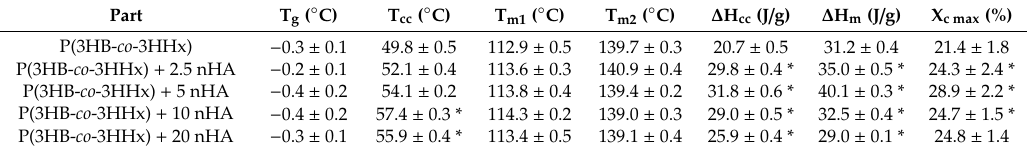
Figure 3. Differential scanning calorimetry (DSC) thermograms taken during second heating of the injection-molded poly(3-hydroxybutyrate- co -3-hydroxyhexanoate) [P(3HB- co -3HHx)] / hydroxyapatite nanoparticle (nHA) parts. Table 5. Thermal properties of the injection-molded poly(3-hydroxybutyrate- co -3-hydroxyhexanoate) [P(3HB- co -3HHx)] / hydroxyapatite nanoparticle (nHA) parts in terms of glass transition temperature (T g ), cold crystallization temperature (T cc ), melting temperatures (T m1 and T m2 ), cold crystallization enthalpy ( ∆ H cc ), melting enthalpy ( ∆ H m ), and maximum degree of crystallinity ( χ c max ).